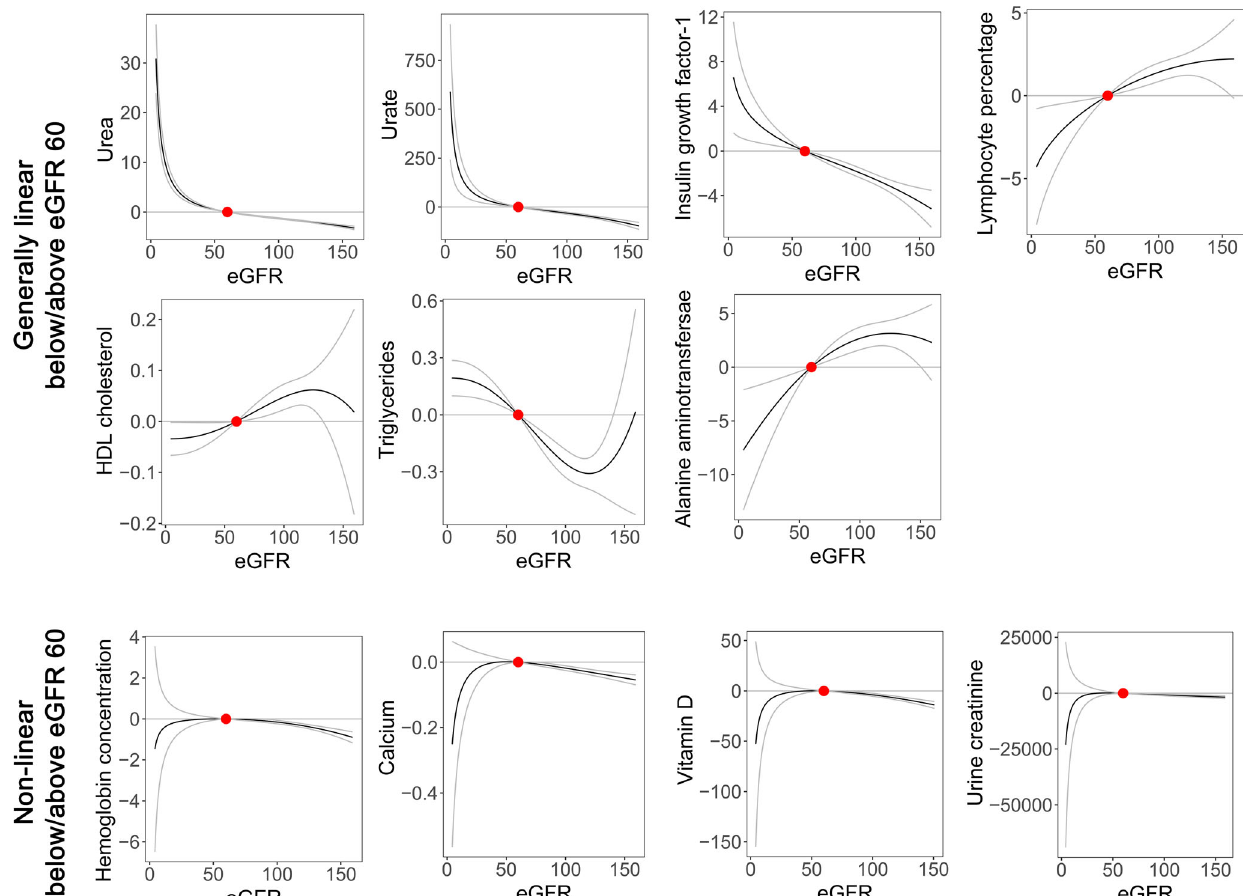
Fig. 3 Nonlinear Mendelian randomization analysis plots. The fractional polynomial method of degree 2 was implemented to illustrate the shapes of causal estimates according to eGFR values. The eGFR values were calculated based on the creatinine – cystatin C CKD-EPI equation in the UK Biobank (available in 321,024 individuals). Age, sex, and 10 genetic principal components were included as adjusted covariates. The reference points (red dots) were set to eGFR 60 mL/min/1.73 m 2 , which is a conventional threshold to indicate reduced kidney function. The biochemical parameters for which the causal estimates were consistently signi fi cant in the summary-level MR were assessed by nonlinear MR analysis. The gray lines indicate the 95% con fi dence interval. The unit of eGFR was mL/min/1.73 m 2 , and the unit of measurements for biochemical parameters were as follows: hemoglobin concentration (grams/deciliter), lymphocyte percentage (percent), urine creatinine (micromole/L), alanine aminotransferase (U/L), urea (mmol/L), calcium (mmol/L), HDL cholesterol (mmol/L), insulin-like growth factor-1 (mmol/L), triglycerides (mmol/L), urate ( µ mol/L), and vitamin D